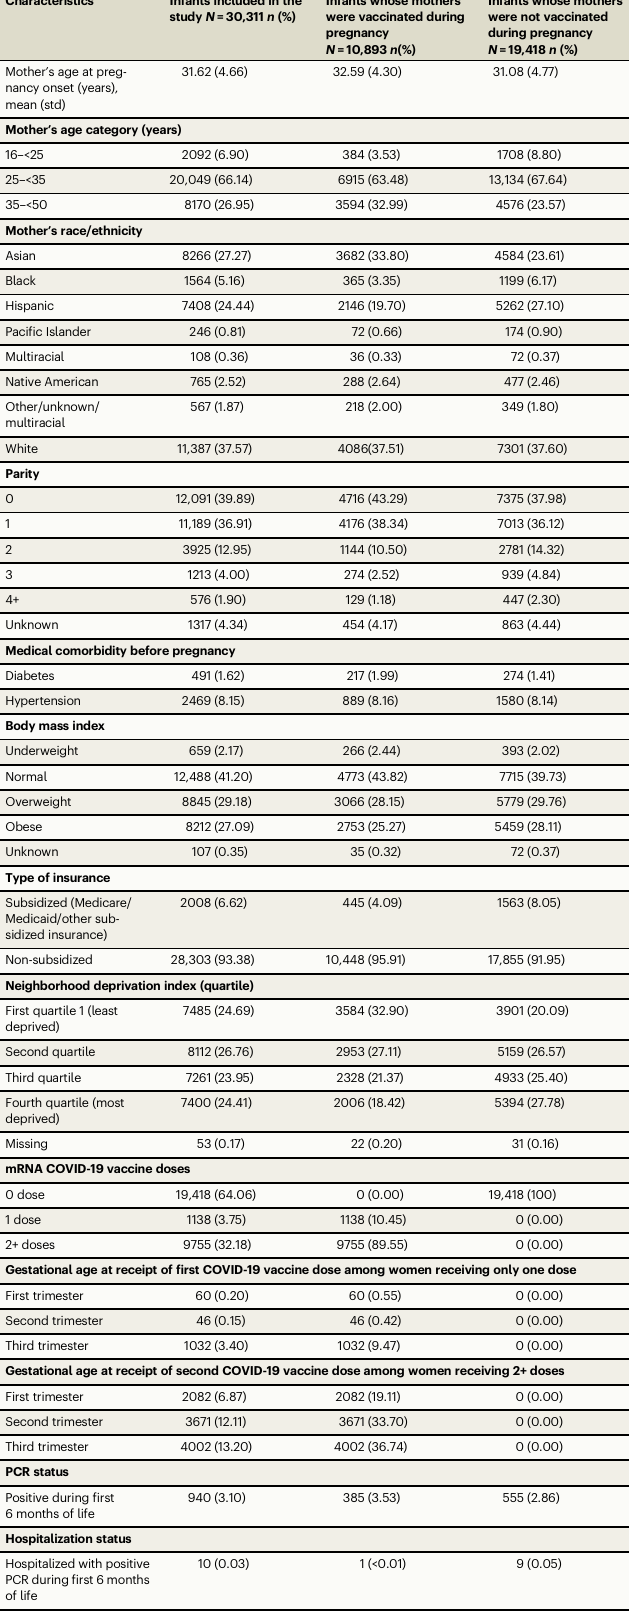
Table 1 | Characteristics of the study population: infants born at Kaiser Permanente Northern California December